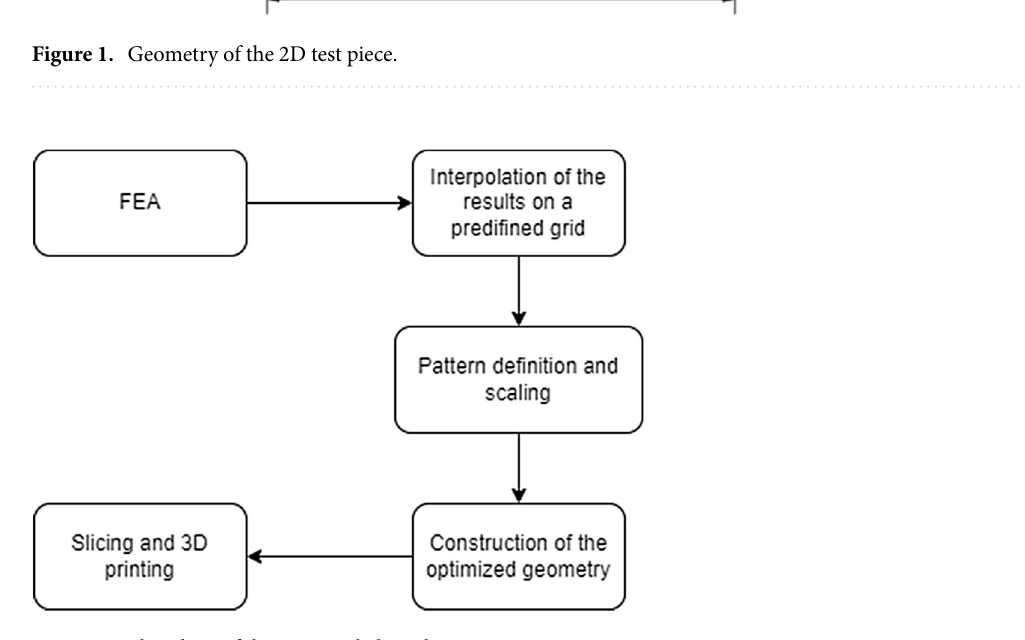
Figure 2. Flowchart of the proposed